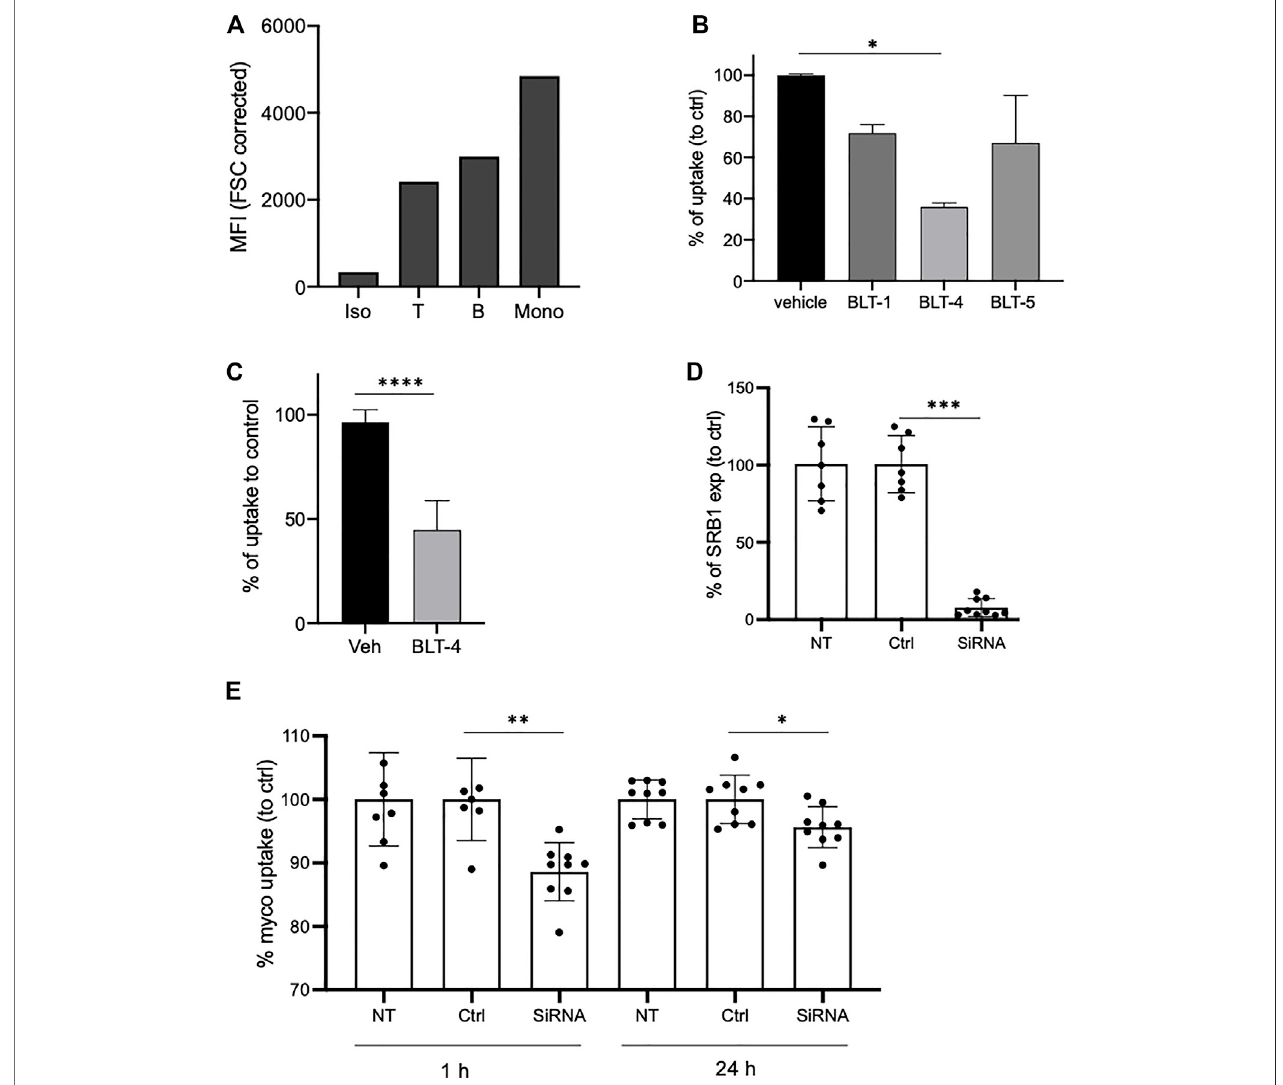
FIGURE 6 | SR-B1 partly contributes to uptake of mycolactone in monocytes. (A) SR-B1 expression as measured by fl ow cytometry in human blood T cells (T), B cells or monocytes (Mono) compared to isotype labeling (Iso). Data are shown as mean fl uorescence intensities (MFI) normalized to cell size (FCS corrected). (B) Incorporation of Bdpy-ML into puri fi ed human primary monocytes after 1 h in presence of vehicle or of the BLT inhibitors: BLT-1 (10 µM), BLT-4 (75 µM), and BLT-5 (150 µM). Dataare shown aspercentage ofuptake tocontrol (vehicle) and are means ± SD oftriplicates. Test one-way Anova, * p < 0.1. (C) Incorporation ofBdpy- MLintoundifferentiatedTHP-1cellsafter1 hinpresenceofvehicle(Veh)orBLT-4(75 µM).Gateonviablecells.Dataareshownaspercentageofuptaketocontrol(Veh) and are means ± SD of 3independent experiments. Test Mann-Whitney, **** p < 0.0001. (D) SR-B1 expression in non-transduced cells (UT), cells transduced with non- targeting siRNA (Ctrl) or with SR-B1 siRNA (siRNA). Data are expressed as percentage to control and are means ± SD of 3 independent experiments with at least 2 replicatespergroup. (E) Bdpy-MLuptakeinnon-transduced(NT)ortransducedTHP-1cellswithnon-targetingsiRNA(Ctrl)orwithSR-B1siRNA(siRNA),after1or24 h of incubation with Bdpy-ML. Data are means ± SD of 3 independent experiments with at least 2 replicates per group, expressed as percentage to control. Test Mann- Whitney, * p < 0.1, ** p < 0.01, *** p < 0.001.